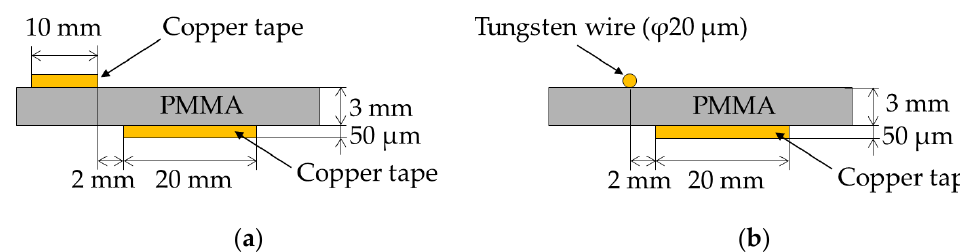
Figure 2. Schemes of the plasma actuators: ( a ) plate-PA; ( b ) wire-PA.